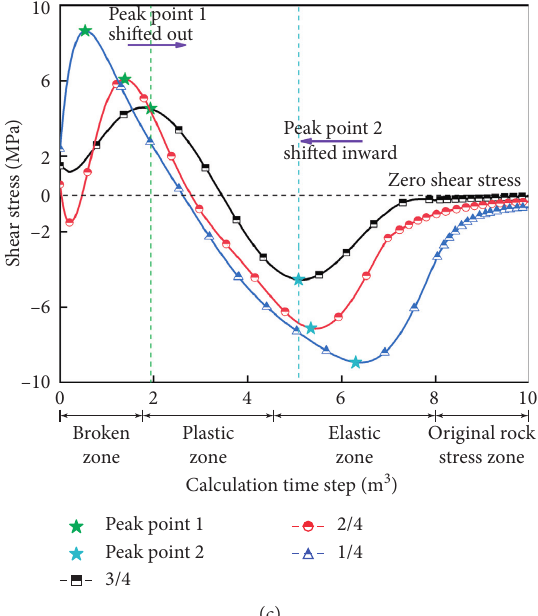
Figure 6: Distribution curve of stress component in different parts of pillar. (a) Vertical stress. (b) Horizontal stress. (c) Shear